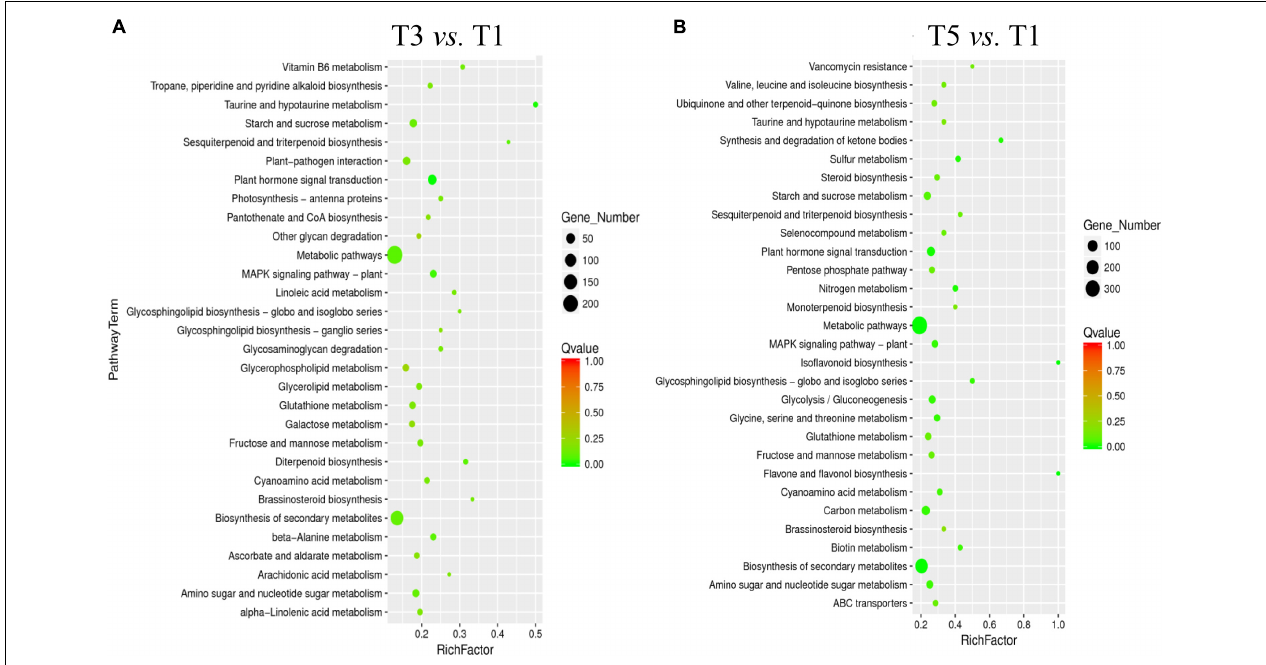
FIGURE 5 | KEGG pathway enrichment for DEGs in (A) T3 vs. T1, and (B) T5 vs. T1. DEGs, differentially expressed genes.